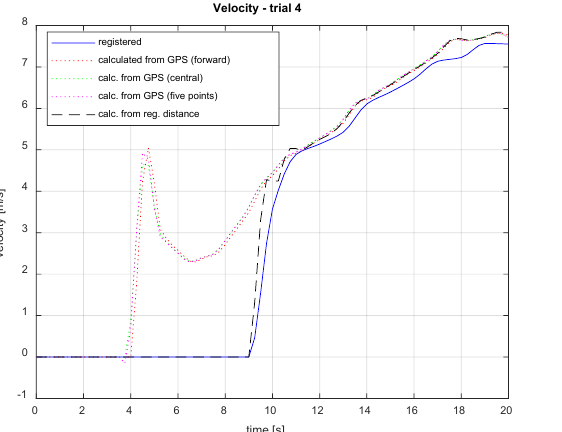
Figure 1. Example of velocity data.